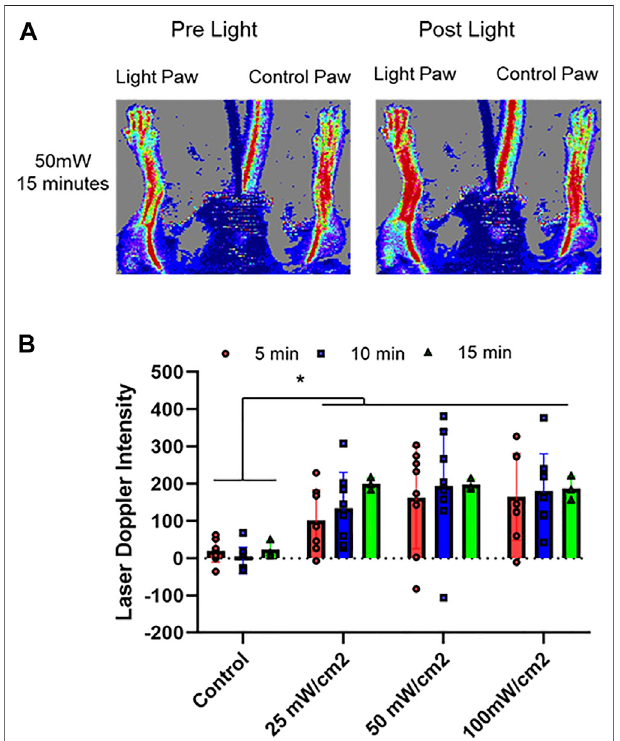
FIGURE 1 | Optimization of vasodilatory effect of red light. 670 nm light wasappliedat25,50,100 mW/cm 2 for5 – 15 mininhindlimbofC57BI/6mice and blood fl ow was measured with Laser Doppler Imaging. The fl ow was measured as a difference between the irradiated limb and the other (control) limb of each animal. (A) : Representative image. (B) : Quanti fi cation of paw perfusion. Mean ± SD is denoted. The Laser Doppler Intensity in irradiated group was signi fi cantly greater than that in the control group ( p < 0.0001). In Friedman ’ s two-way nonparametric ANOVA, a statistical signi fi cance was detected for the exposure duration ( p = 0.0102), but not for power density ( p = 0.177).